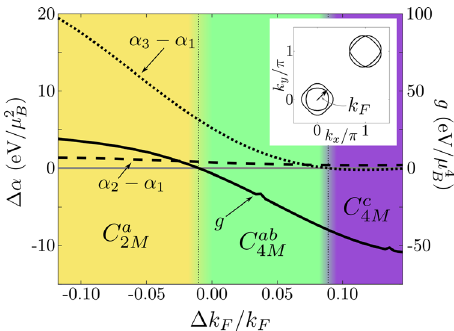
Fig. 5 Theoretical phase diagram. Evolution of Landau parameters α i and g (constants from the quadratic and quartic parts of the Landau free energy expansion) as a function of change in Fermi momentum, 4 k F = k F . This models the evolution of the leading magnetic instability with P substitution on the As site, with larger P concentrations corresponding to a larger Fermi surface. The left vertical axis represents the relative difference in these values for the constants, 4 α , and the right axis represents values for g . The transitions between different instabilities correspond to when g drops below zero and when α 3 (cid:2) α 1 becomes smaller than α 2 (cid:2) α 1 . Inset is a snapshot of the Fermi surface in the 2Fe/unit